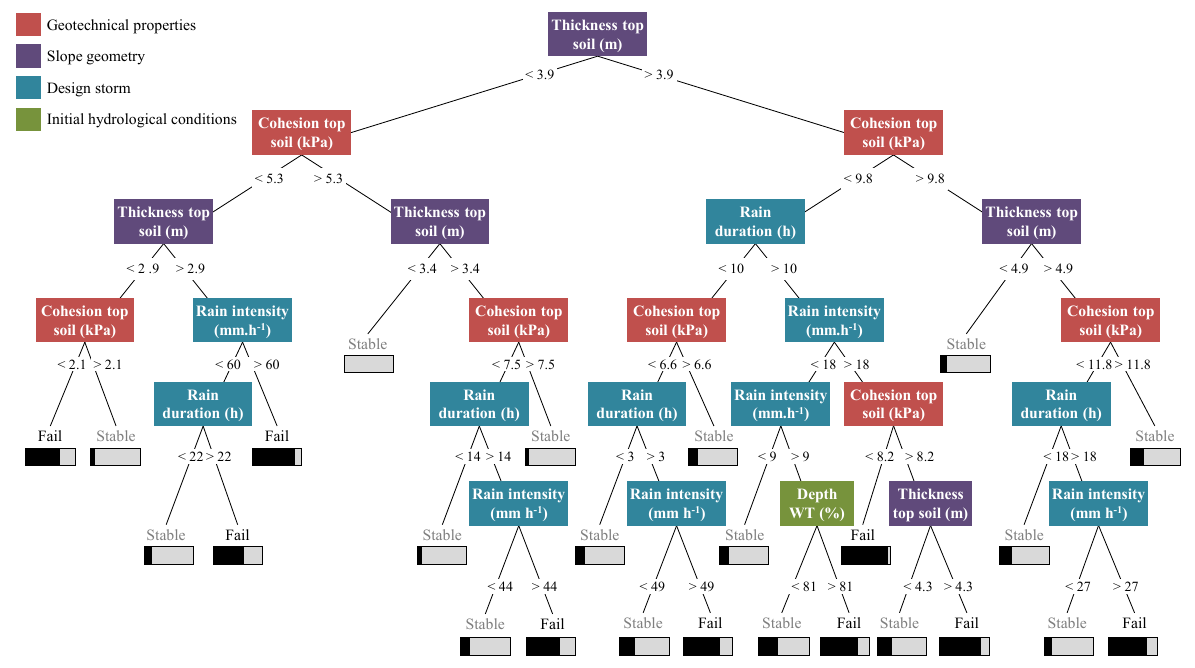
Figure 5. Classification tree of slope response. Each interior node corresponds to one of the analysed uncertain input factors (model param- eters, boundary conditions and design storm properties). The bar under each leaf shows the proportion of simulations that resulted in slope failure (black) or stability (grey) for that